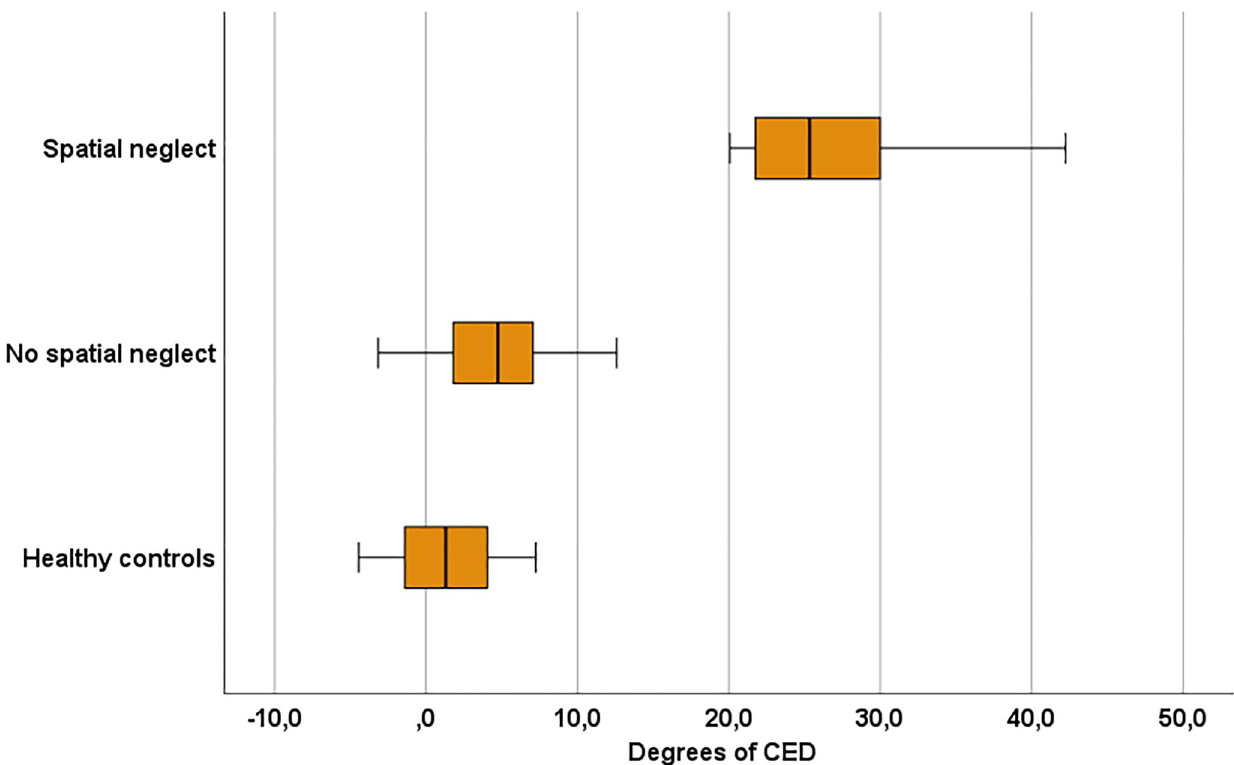
Fig 3. Degree of the horizontal eye deviation of the three subject groups. Positive values indicate horizontal deviation towards the ipsilesional side; negative values horizontal deviation towards the contralesional side. The CED of each patient was calculated through the average of the deviation of both eyes. The boxplot shows the median and quartile distribution of the CED on the different subject groups.